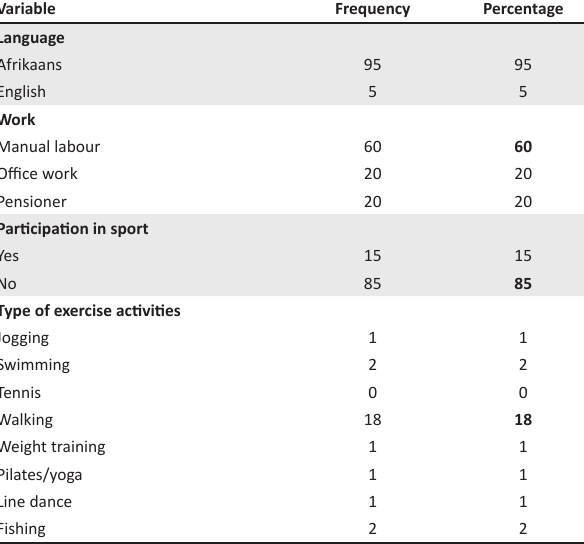
TABLE 3: Results for demographic variables (categorical), n = 100. Variable